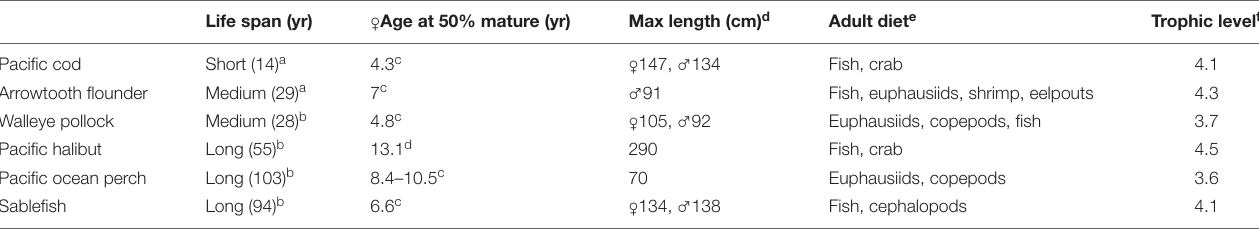
TABLE 1 | Life history traits of groundfish in the Gulf of